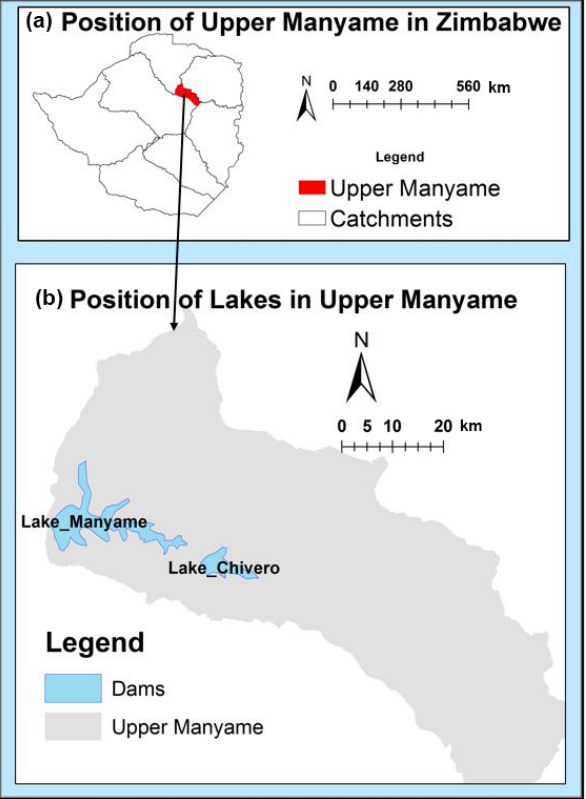
Figure 1. Map of study area (first: Upper Manyame in Zimbabwe, second: Lakes Chivero and Manyame in Upper